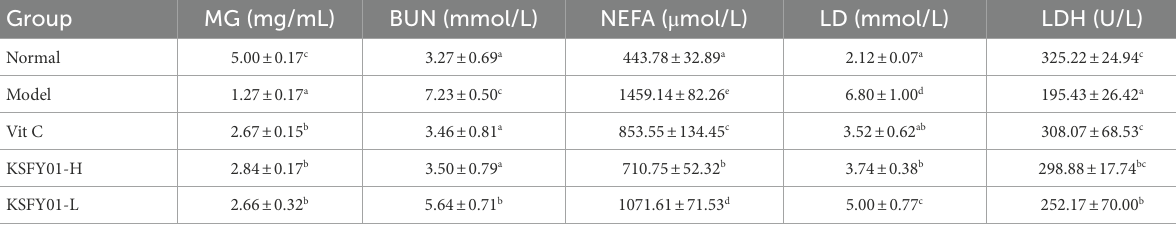
TABLE 2 The MG, BUN, NEFA, LD, and LDH levels in aging mouse.